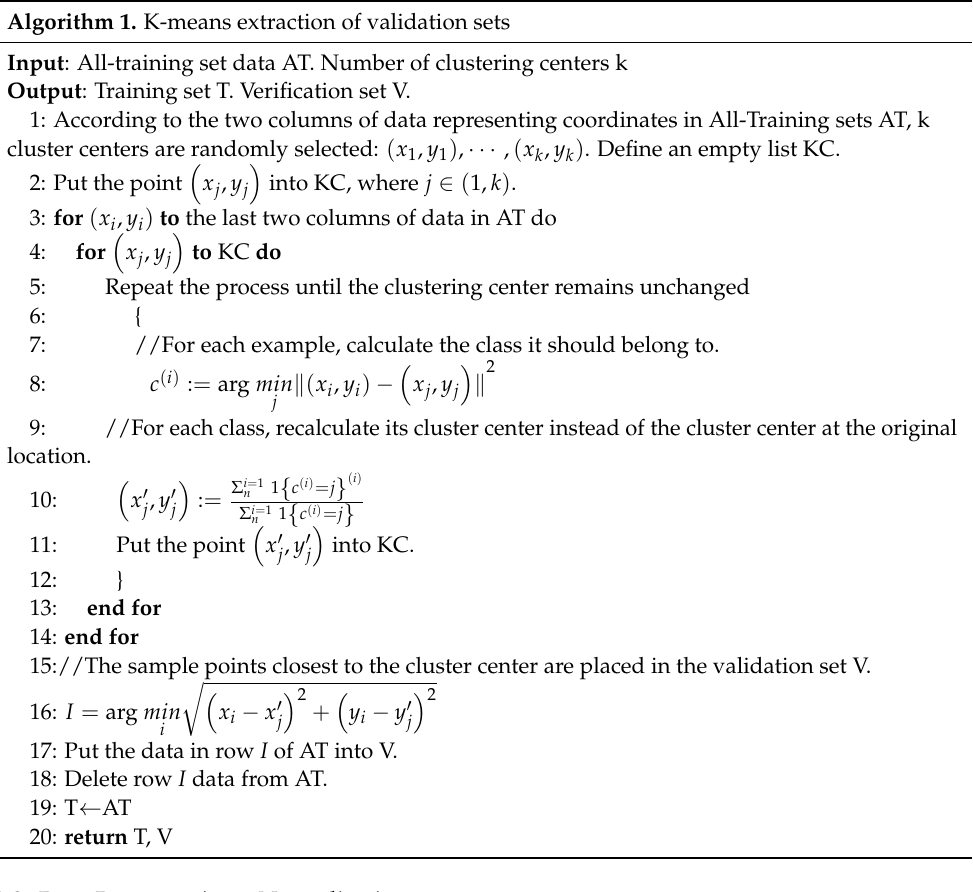
Algorithm 1. K-means extraction of validation